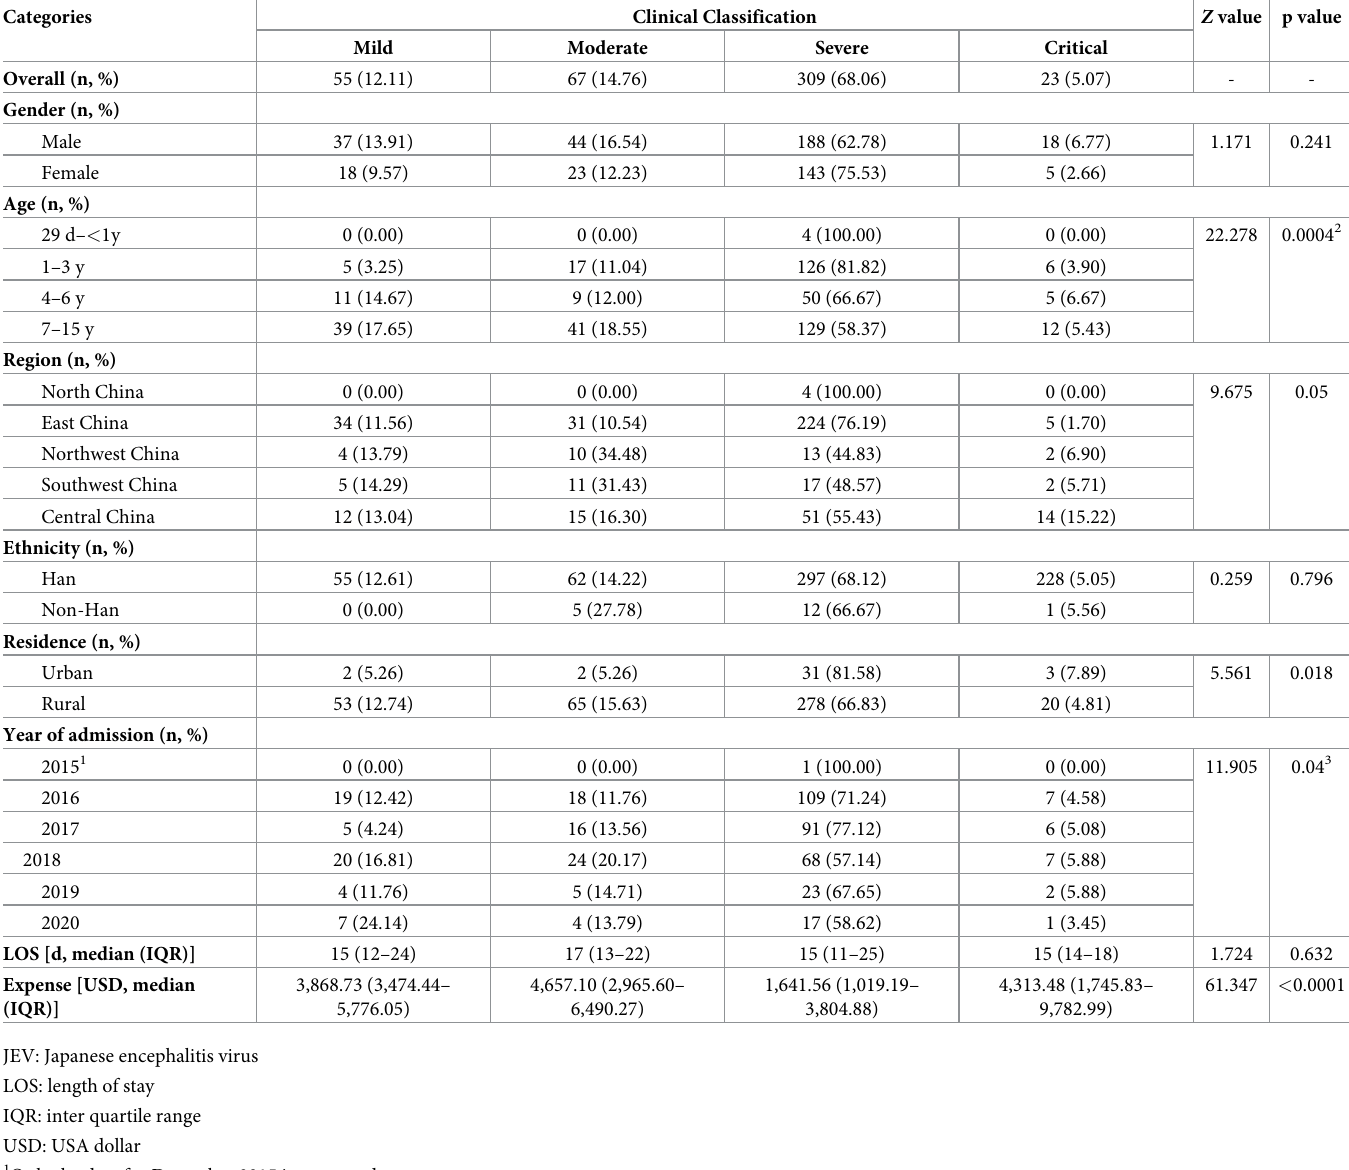
Table 3. The general sociodemographic characteristics and disease burden of JEV infection categorized by clinical classification during pediatric hospitalizations from December 2015 to December